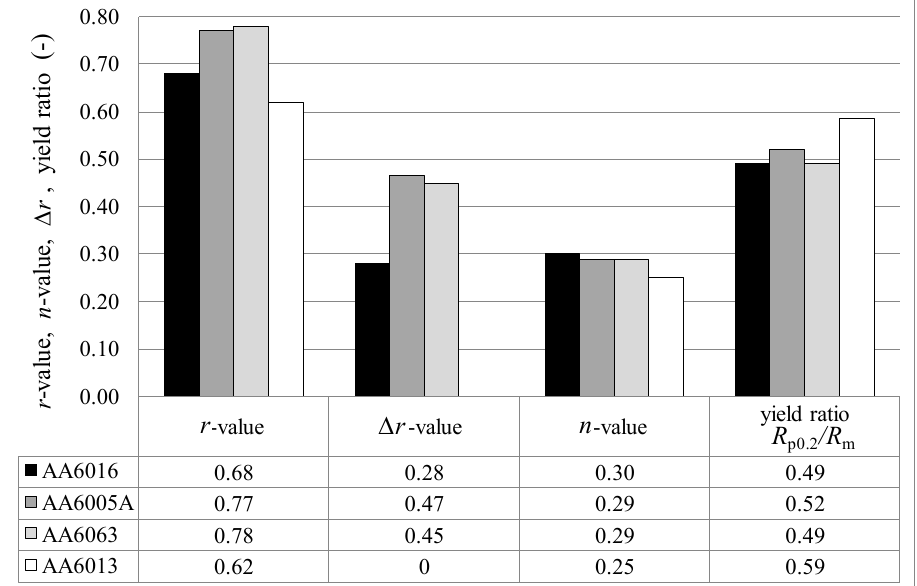
Figure 9. Vertical anisotropy r (LT), strain hardening exponent n (LT), plane anisotropy ∆r (according Equation (1)) and R after sheet